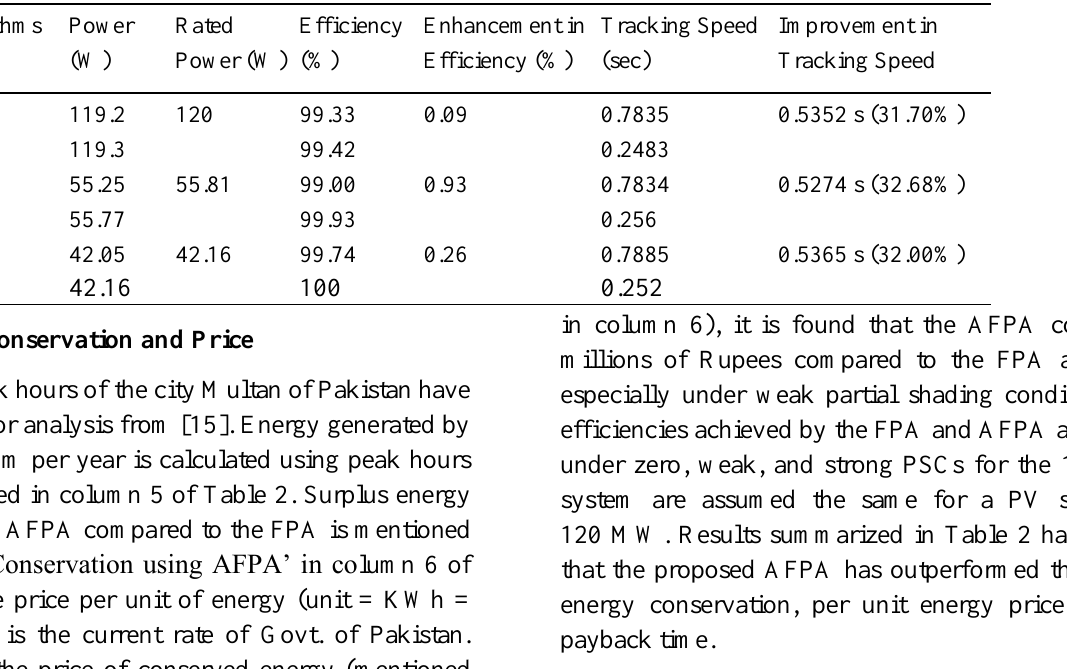
Performance Comparison of AFPA and FPA